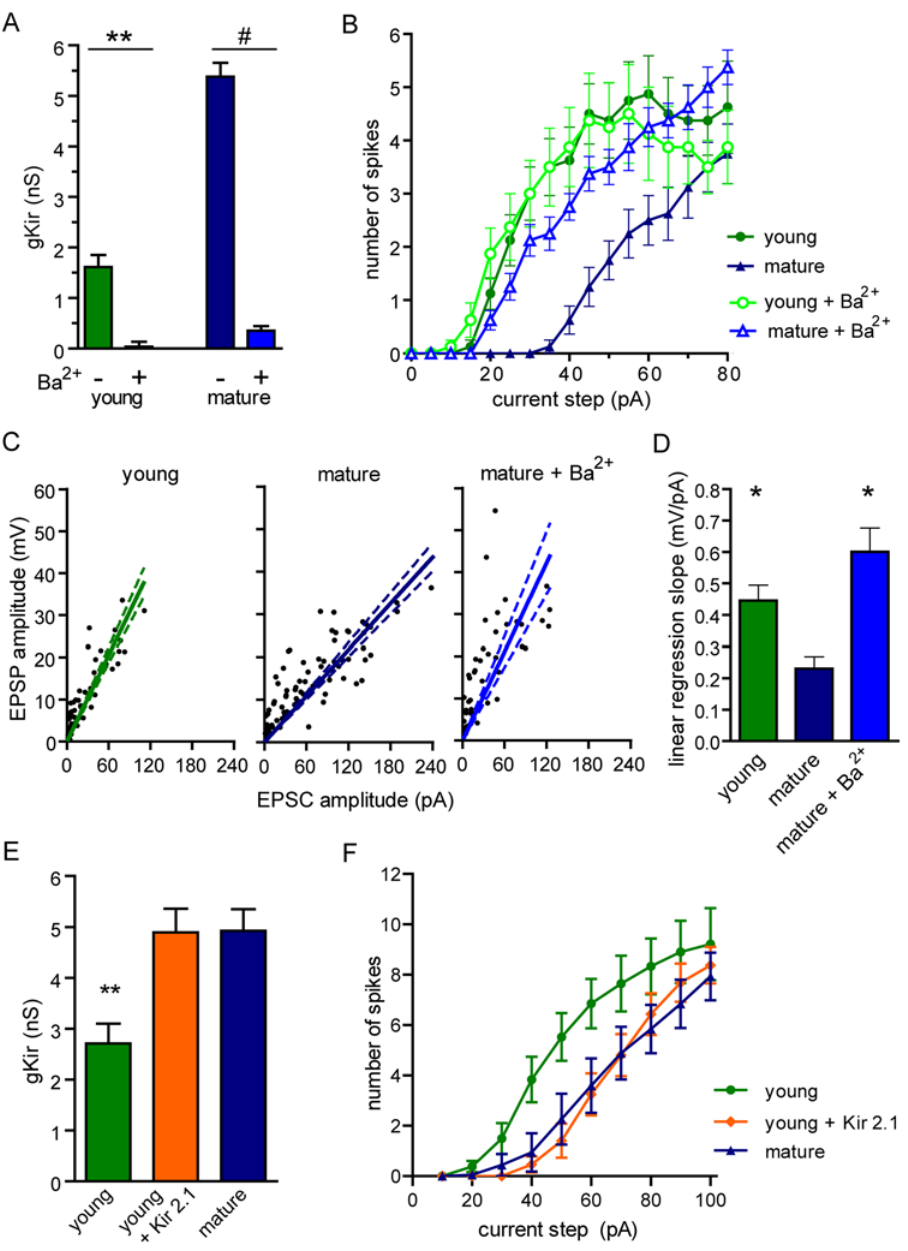
Figure 6. Control of the excitability of newborn cells by Kir channels. (A) Kir conductance in the absence or presence of BaCl 2 . (**) denote p , 0.001, ( # ) denote p , 0.0001 as analyzed by ANOVA followed by a Bonferroni’s test, with N=24 (young), 8 (young + Ba 2 + ), 28 (mature) and 23 (mature + Ba 2 + ). (B) The number of spikes elicited by depolarizing current steps (5 pA, 200 ms) reveals that Kir blockade by Ba 2 + enhances suprathreshold excitability of mature but not young neurons. Statistical differences were found between young vs. mature ( p , 0.01), mature vs. mature + Ba 2 + ( p , 0.05) and mature vs. young + Ba 2 + ( p , 0.01), but not young vs. young + Ba 2 + (p=0.11). N=8 (for all groups), analysis performed by ANOVA for repeated measures followed by a Bonferroni’s test. (C) Kir blockade by Ba 2 + increases subthreshold excitability assessed as EPSP / EPSC ratios. N=16 (young) and N=14 (mature and mature + Ba 2 + ). Linear regression plots and the 95% confidence interval are shown (dotted lines). (D) Average slope of linear regressions. (*) denotes p , 0.05 when compared to mature DGCs (ANOVA followed by Bonferroni’s test). (E, F) Overexpression of Kir 2.1 in young DGCs (28–29 dpi). (E) Significant increase in Kir conductance by Kir 2.1 overexpression. (**) denote p , 0.001 and ( # ) denote p , 0.0001 as analyzed by ANOVA followed by a Bonferroni’s test, with N=13 (young–controls –), 12 (young + Kir 2.1) and 9 (mature). (F) The number of spikes elicited by depolarizing current steps (10 pA, 400 ms) indicates that Kir overexpression reduces suprathreshold excitability in young DGCs. Statistical differences were found between young vs. mature and young vs. young + Kir 2.1 (p , 0.01 for both). Analysis performed by ANOVA for repeated measures followed by a Bonferroni’s test with N=11 (young), 9 (young + Kir 2.1) and 6 (mature). doi:10.1371/journal.pone.0005320.g006 chilled solution containing (in mM): 110 choline-Cl 2 , 2.5 KCl, 2.0 Horizontal slices (400- m m thick) were cut in a vibratome (Leica NaH 2 PO 4 , 25.0 NaHCO 3 , 0.5 CaCl 2 , 7 MgCl 2 , 20 dextrose, 1.3 VT1200 S, Nussloch, Germany) and transferred to a chamber Na + -ascorbate, 0.6 Na + -pyruvate, and 4.0 kynurenic acid. containing (in mM): 125.0 NaCl, 2.5 KCl, 2.0 NaH 2 PO 4 , 25.0